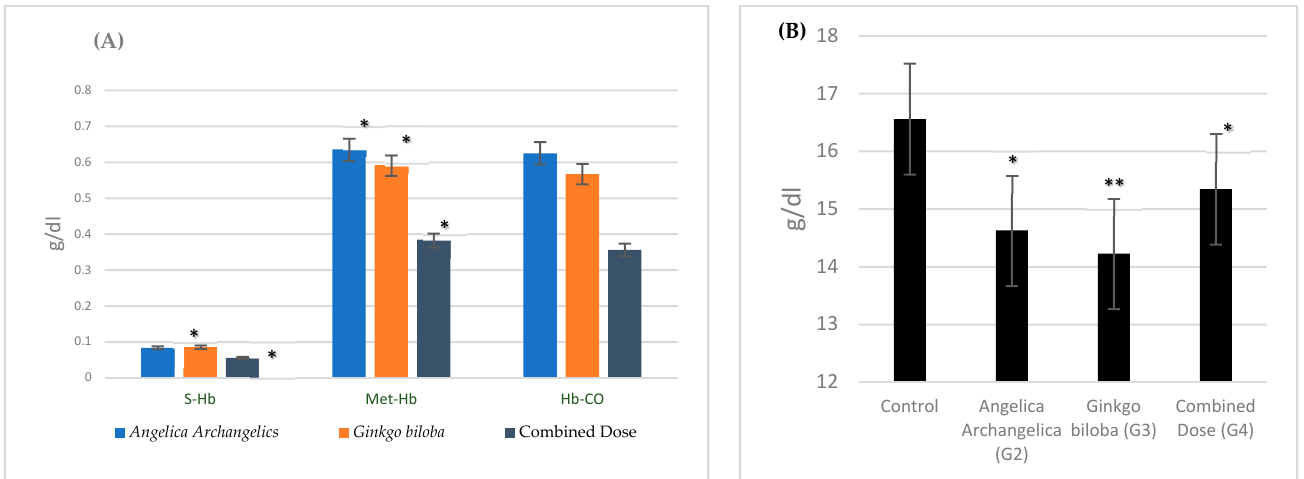
Figure 2. ( A ) Sulfhemoglobin, methemoglobin, and carboxyhemoglobin derivative concentrations in rabbits injected with 68 Ga after antioxidant treatment for seven days. ( B ) Oxyhemoglobin derivative concentrations of rabbits injected with 68 Ga after antioxidant treatment for seven days. * Significant p < 0.05 and ** highly significant p < 0.01.